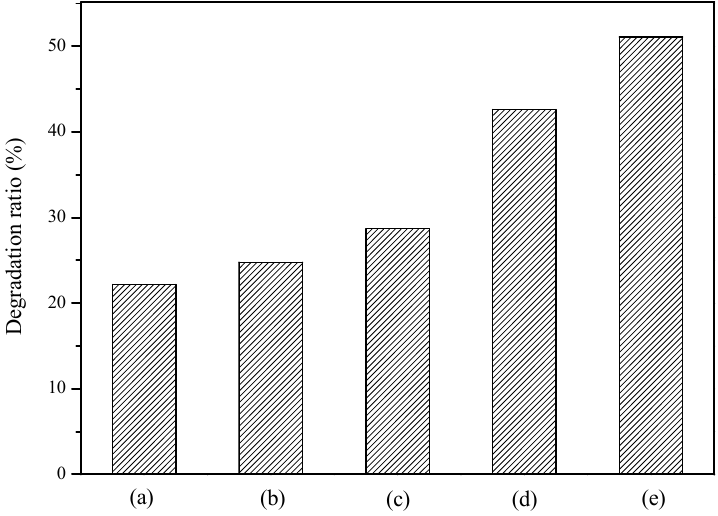
Figure 4. Comparison of photocatalyltic activities with: ( a ) Ni 2+ /K 2 La 2 Ti 3 O 10 , ( b ) Sn 2+ /K 2 La 2 Ti 3 O 10 , ( c ) Ce 2+ /K 2 La 2 Ti 3 O 10 , ( d ) Fe 2+ /K 2 La 2 Ti 3 O 10 , and ( e ) Cu 2+ /K 2 La 2 Ti 3 O 10 .